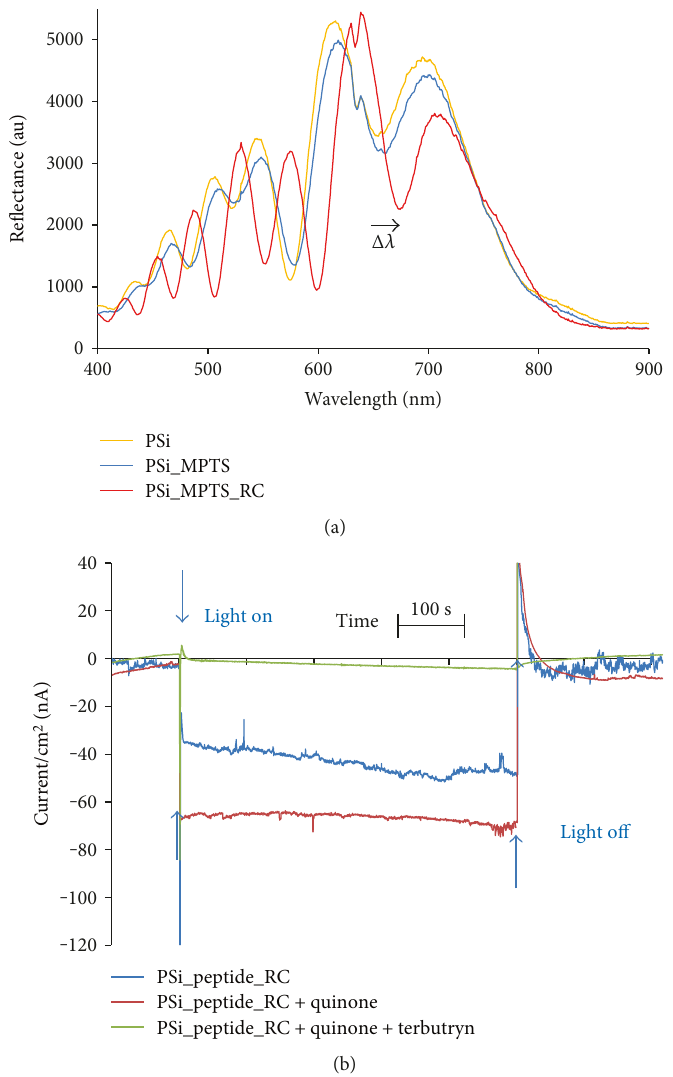
Figure 8: The re fl ection spectrum of the PSi before and after functionalization with RC (a) and light-induced photocurrent with the PSi/RC electrode in the presence of externally added UQ-0 mediator and the inhibitor terbutryn, as indicated. Traces correspond to the signal during consecutive illumination periods. Horizontal and vertical arrows, respectively, indicate the shifts in the speci fi c re fl ection mode after the RC binding and the time when the illumination was switched on or o ff